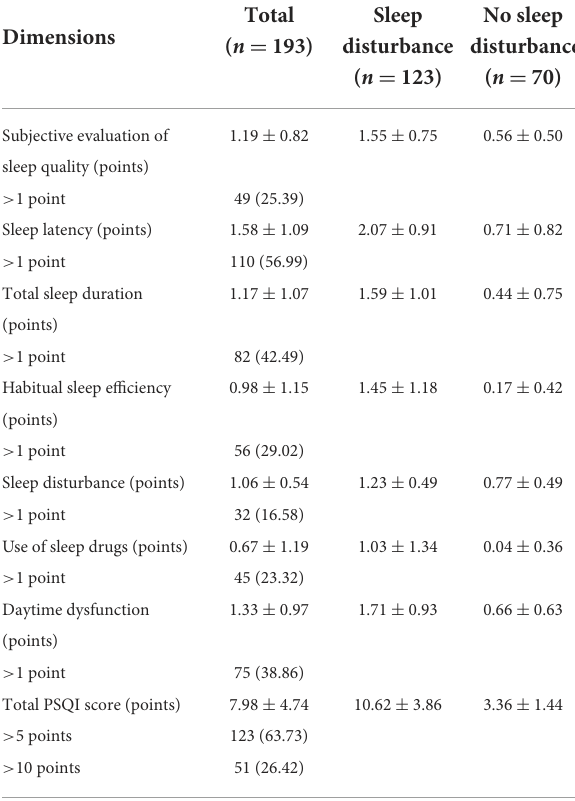
TABLE 2 PSQI score of MHD